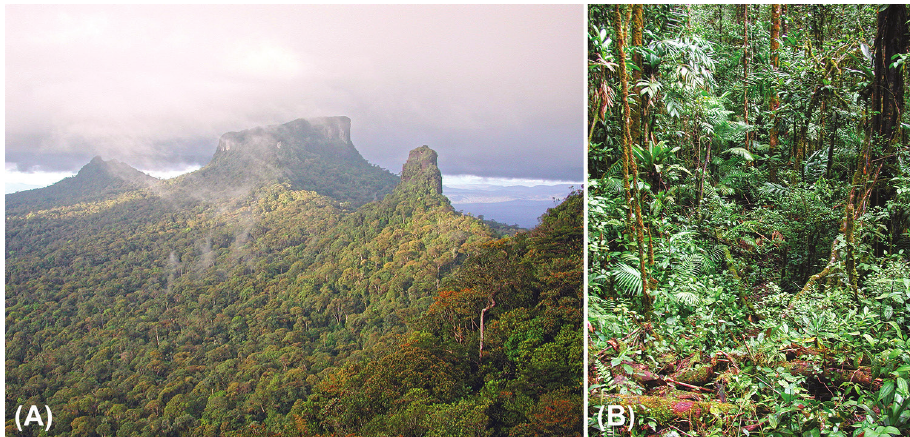
Figure 5. Habitat of Anomaloglossus meansi sp. n. on the Wokomung Massif A photograph (looking NE) of the highest part of the massif; the plateau in the centre of the photo is the tallest part of the entire Wokomung Massif B cloud forest at about 1385 m elevation, habitat of Anomaloglossus meansi sp. n. Photographs courtesy D. Bruce